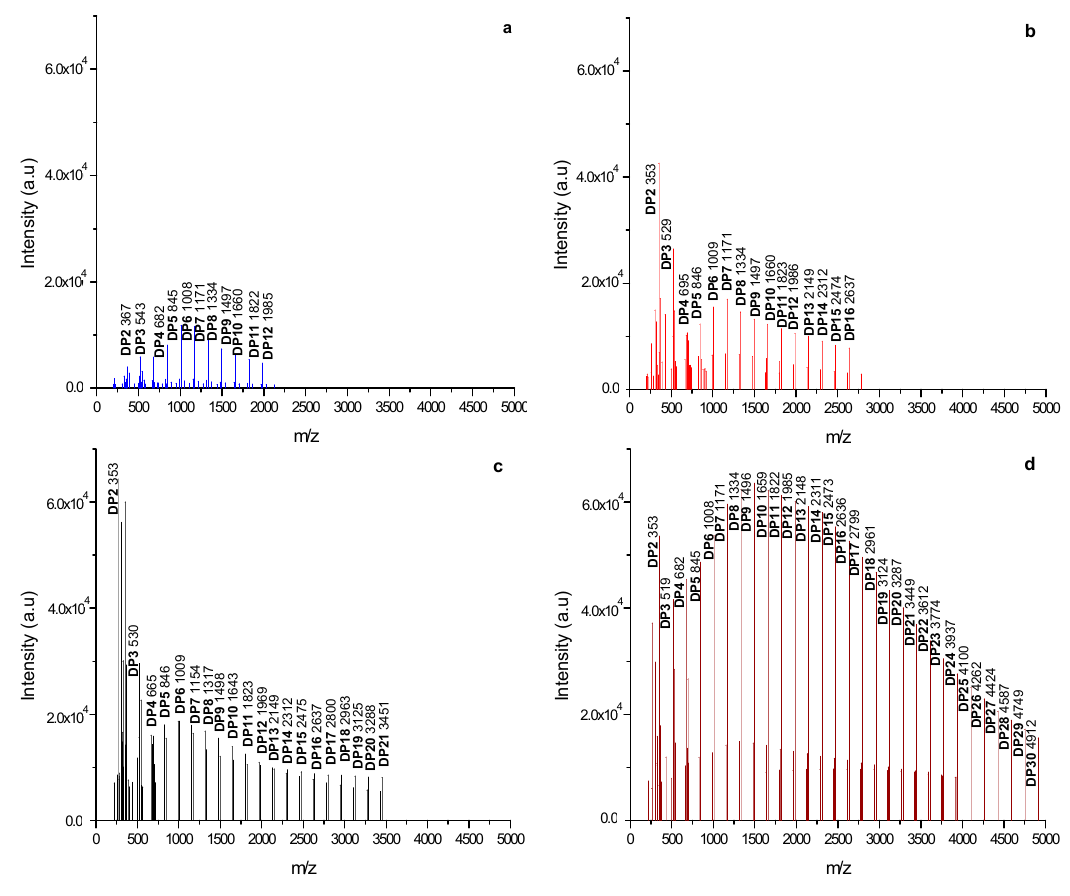
Figure 1. MALDI-TOF spectra of MXs: ( a ) Mc; ( b ) M10; ( c ) M20 and ( d ) M40. Table 1. Molecular weight parameters from the MXs, determined from MALDI-TOF spectrometry experiments. Maltodextrin